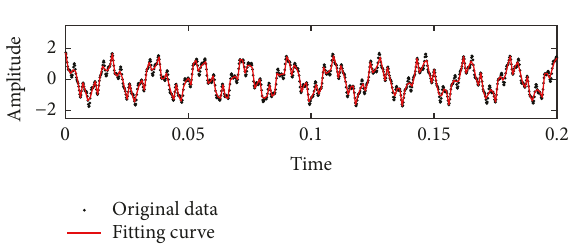
Figure 14: The fitting result by LSSVM. Figure 15: The correction result of outlier.